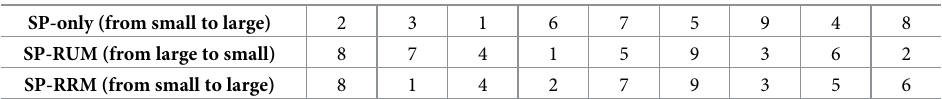
Table 10. The optimal plan ranking for SP-only, SP-RUM and SP-RRM model from small to large. SP-only (from small to